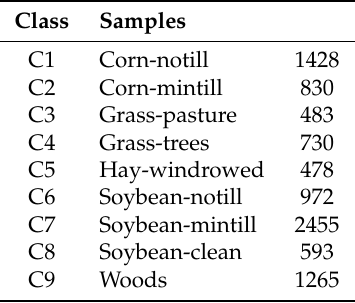
Table 9. Ground truth classes for the Indian Pines dataset and their corresponding numbers of samples.